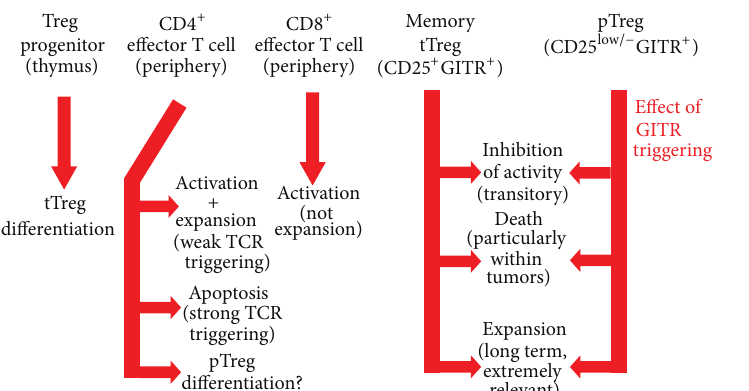
Figure 1: Role of GITR in CD4 + and CD8 + T cells and Tregs (thymus-derived Tregs, tTregs, and peripherally derived Tregs, pTregs) resulting from studies on rodents and